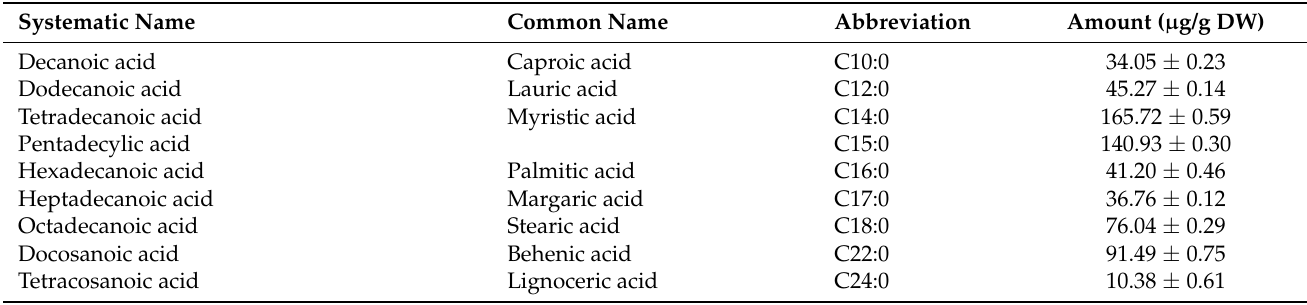
Table 3. Fatty acid contents of UI dried